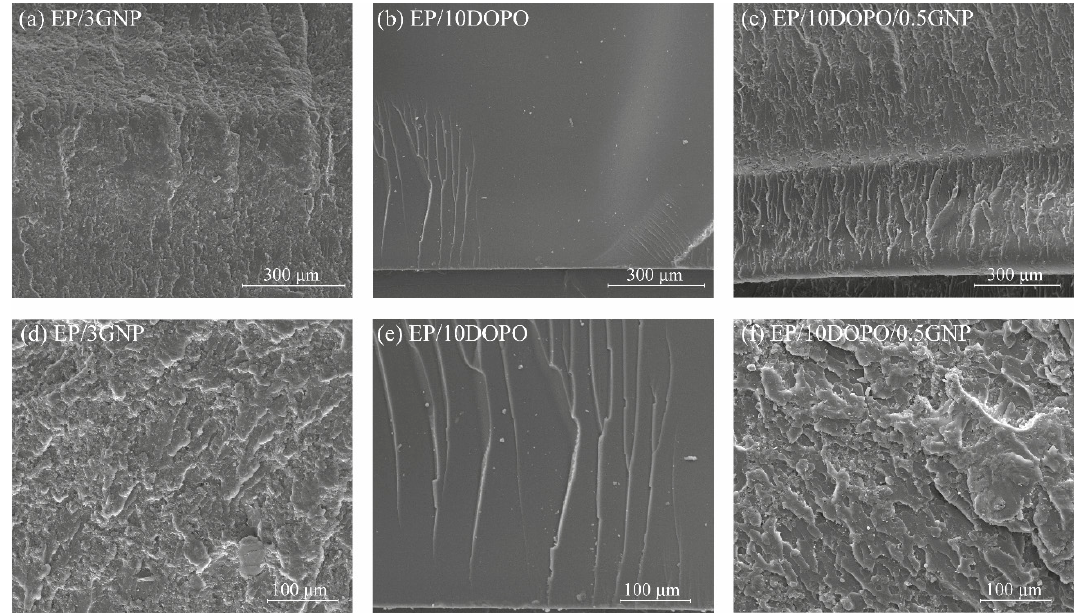
Figure 3. Scanning electron microscopy (SEM) images of fracture surface after three-point bending test of ( a ), ( d ) EP/3GNP, ( b ), ( e ) EP/10DOPO, and ( c ), ( f ) EP/10DOPO/0.5GNP.